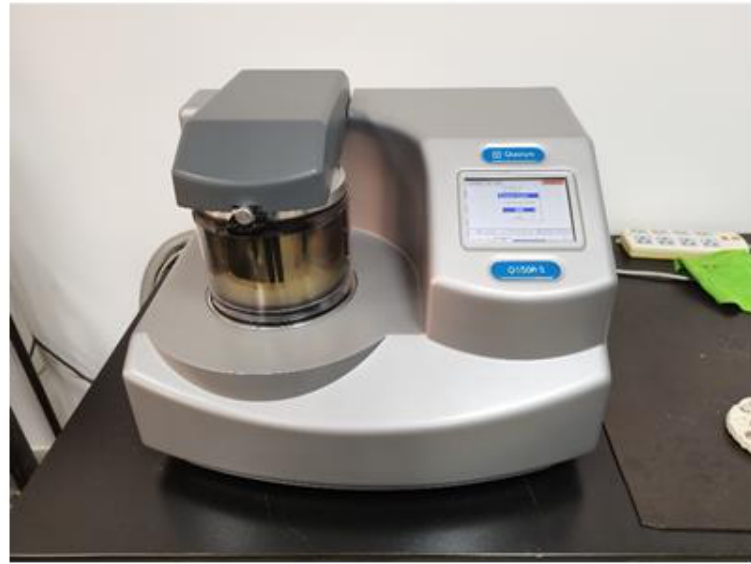
Figure 6. Gold spraying equipment.